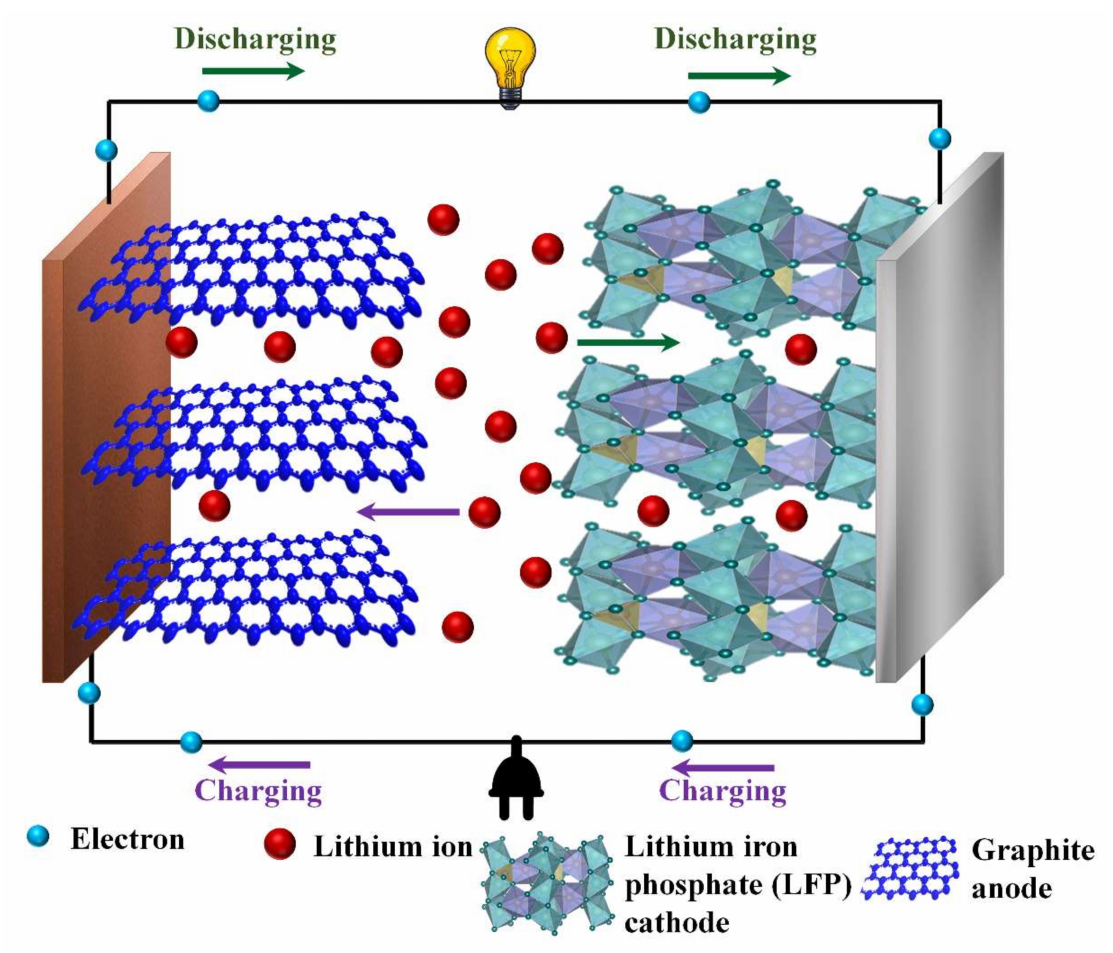
Figure 6. Schematic demonstration of typical LIB comprising of graphite as anode, lithium iron phosphate as cathode, and lithium salt-based